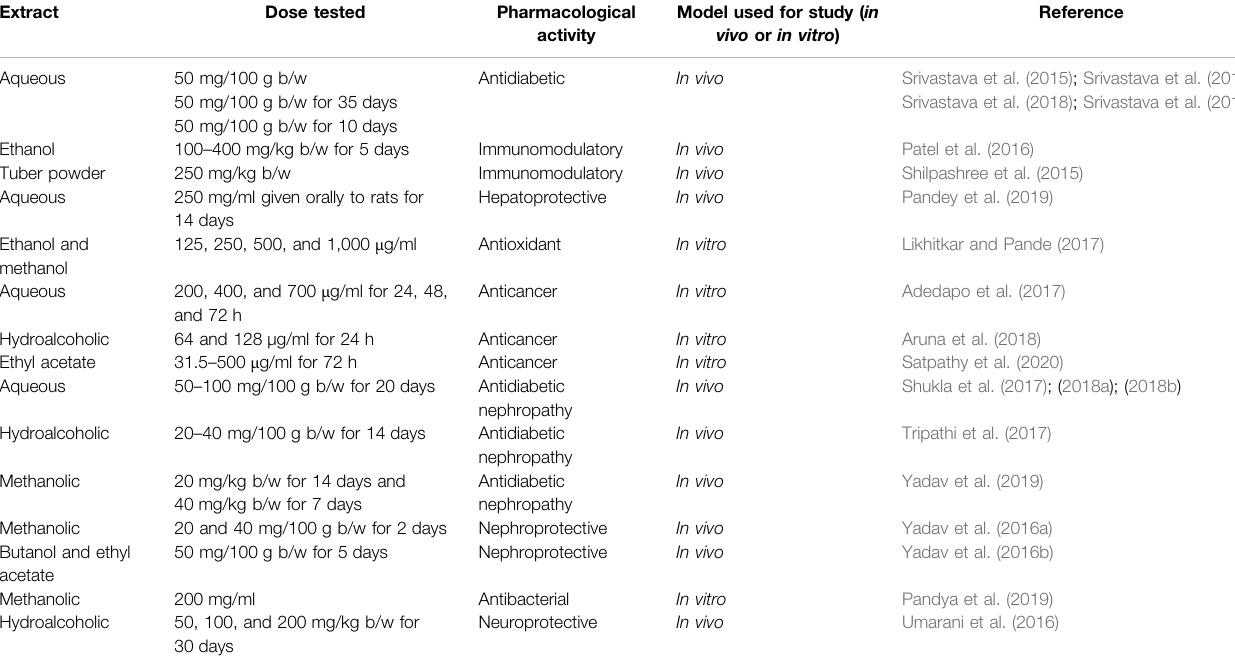
TABLE 1 | Pharmacological activities of tuber extract of Pueraria tuberosa .